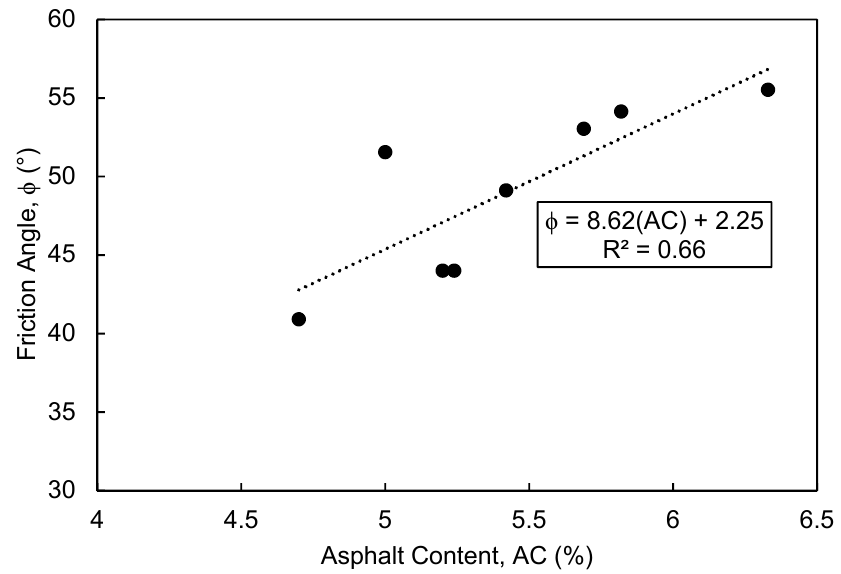
Figure 7. Asphalt content of the RAP versus friction angle [1 2 ,17,18,25].